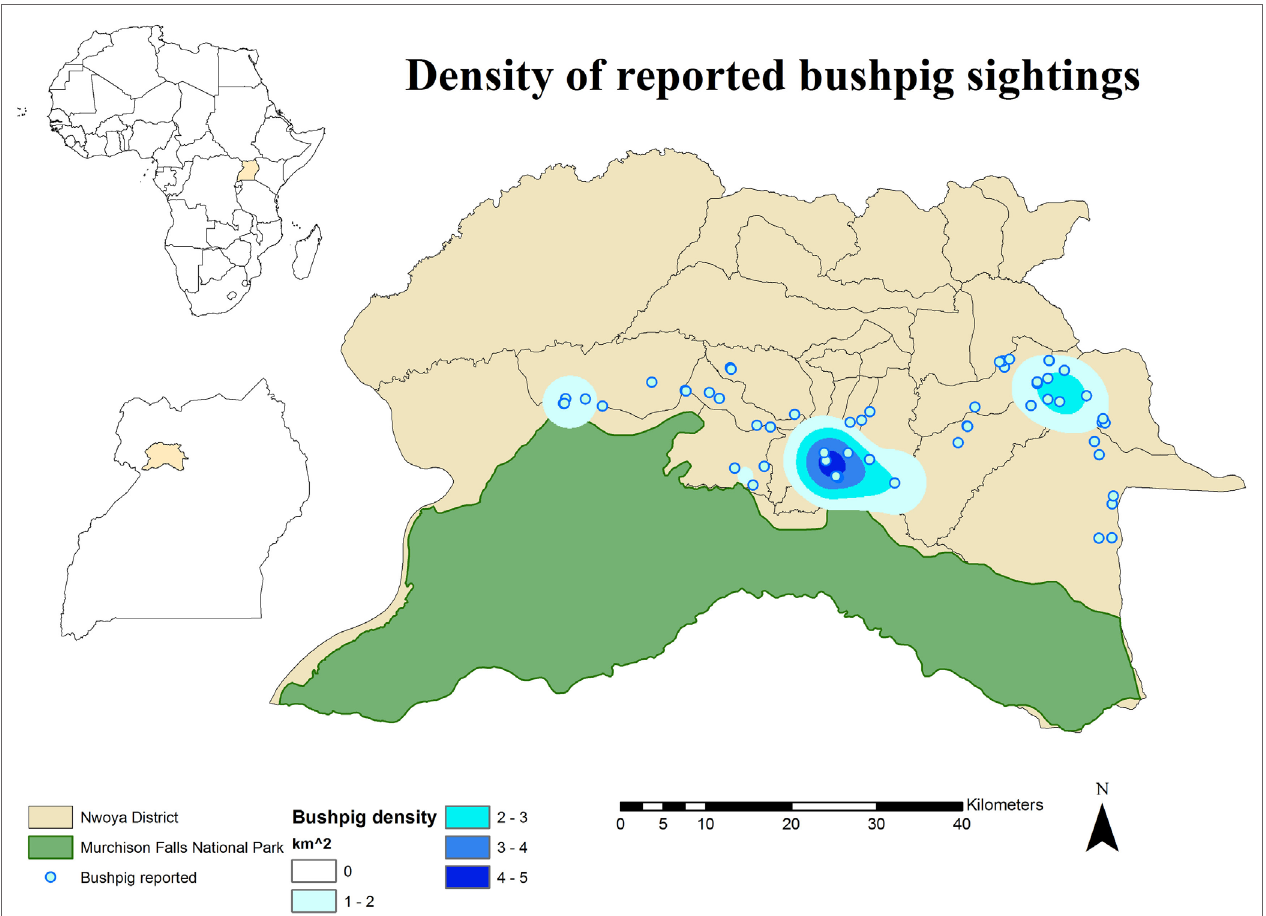
FigUre 3 | spatial distribution of 233 pig owning households individually interviewed in southern nwoya district, Uganda, near Murchison Falls national Park, 2015 and kernel density estimation of bushpig sightings distribution as reported by the interviewers .